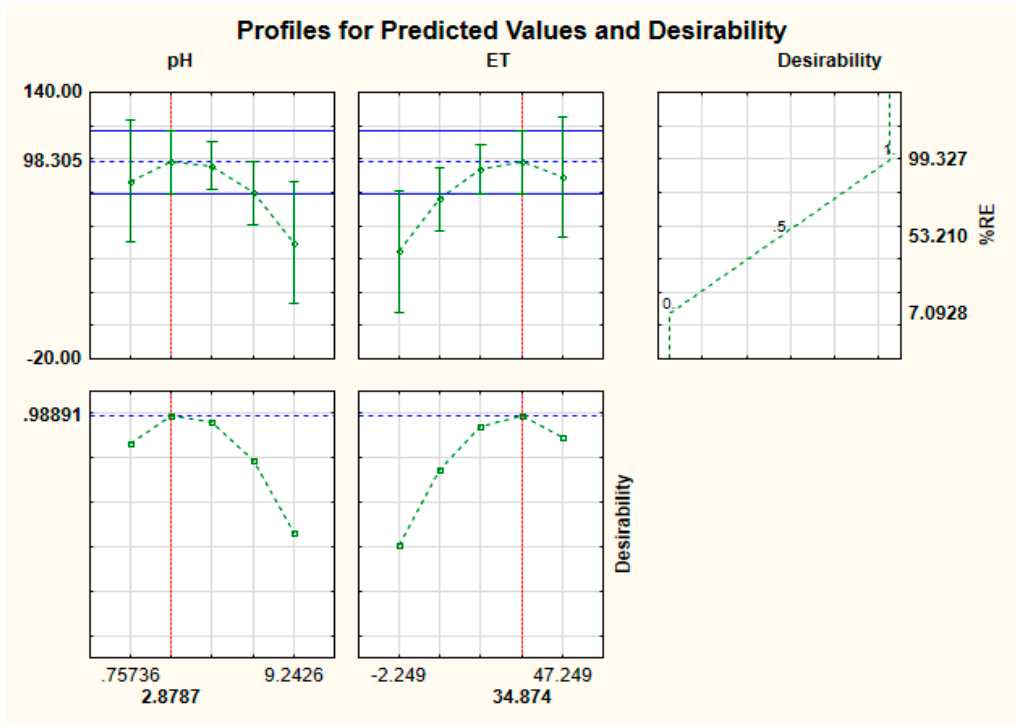
Figure 3. Desirability function for optimization of the adsorption process.